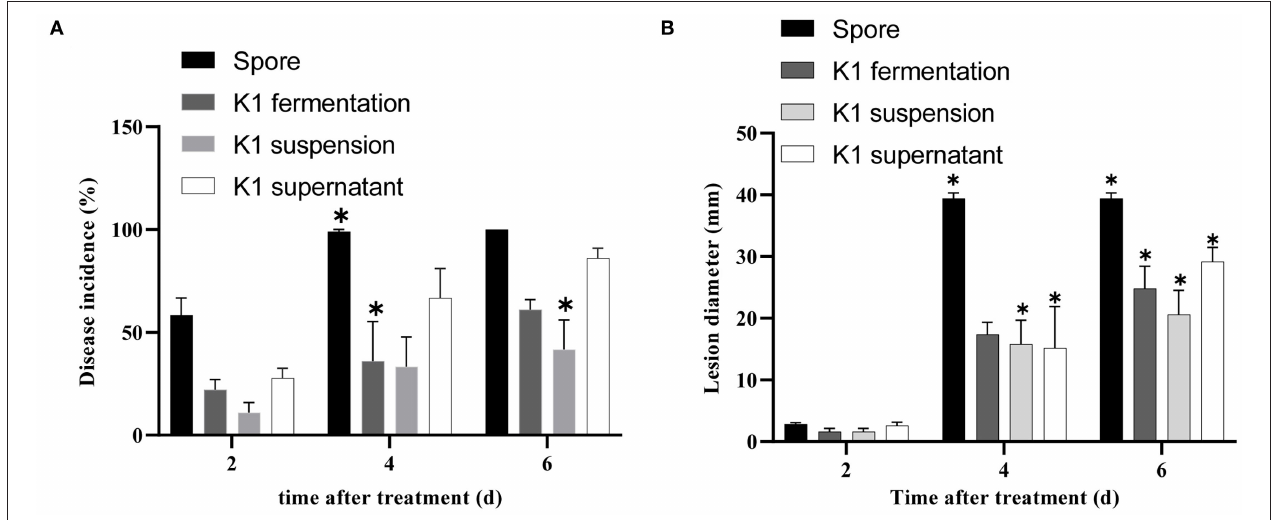
FIGURE 6 | Efficacy of Bacillus K1 on grape fruit against Botrytis cinerea in vivo . (A) Disease incidence of gray mold on grape fruit after treatment with K1 fermentation, supernatant, and suspension. (B) Lesion diameter on grape fruit with different treatments. Three independent replicates were conducted for each treatment, 12 grapes were used for each replication. The experiment was conducted thrice. Values are means of three replicates. Error bars represent standard error of the mean, asterisks (*) represent significant differences according to a t -test ( p < 0.05).